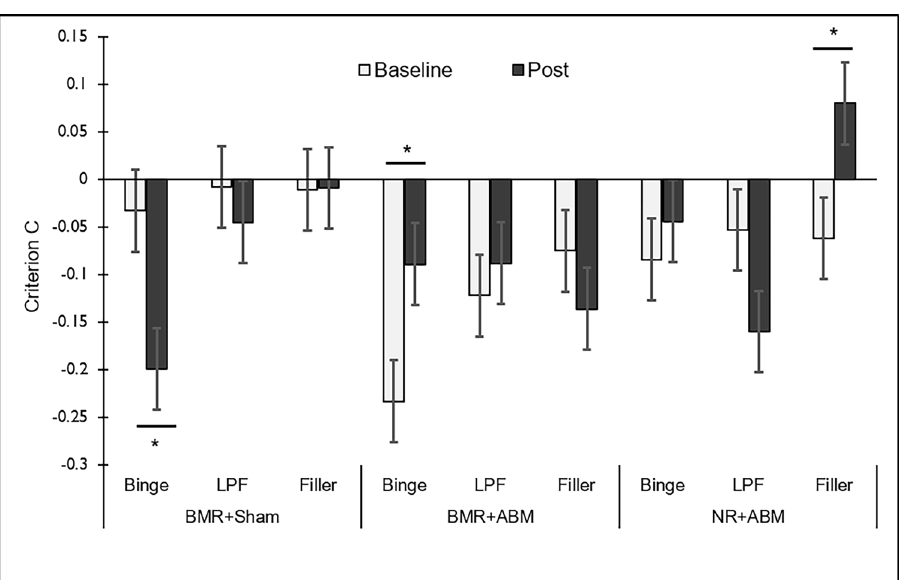
Figure 1. Changes in commission bias (Criterion C) across study sessions. Reductions in binge food commission (‘go’ bias) were seen in BMR + RIT , along with a shift in bias towards non-food images in NR + RIT . BMR + Sham showed an unfavourable shift in bias towards binge images, in line with a worsening of ‘go bias’ due to sham training. Bars are group mean ± SEM. *p <